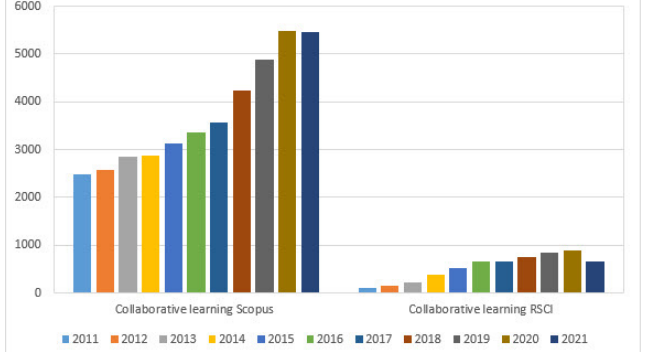
Figure 1. Number of publications in the Scopus and the Russian Science Citation Index databases in the category “collaborative learning” by